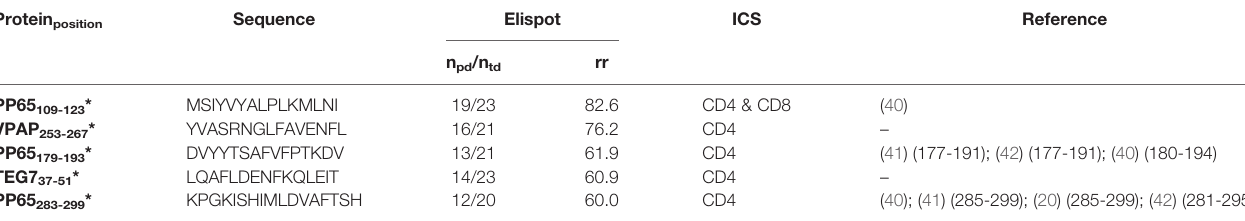
TABLE 3 | ELISpot and ICS results of re-evaluated published HCMV epitopes and epitopes from previous projects. Protein position